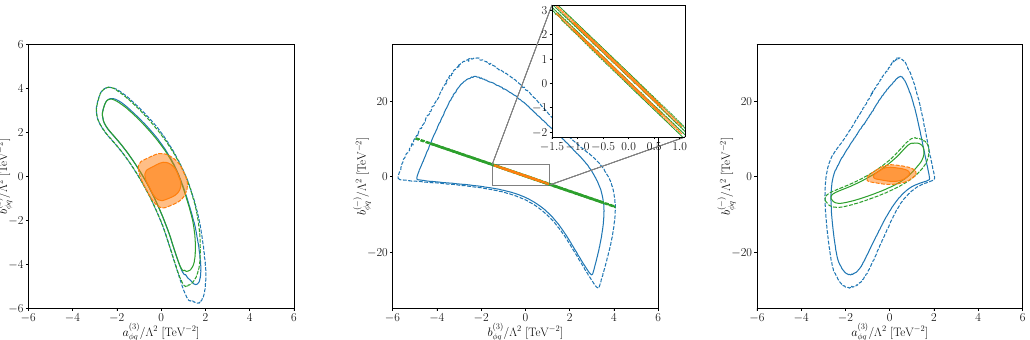
( m ) = C (1) and C (3) ( m ) − C (3) t t φq φq φq φq